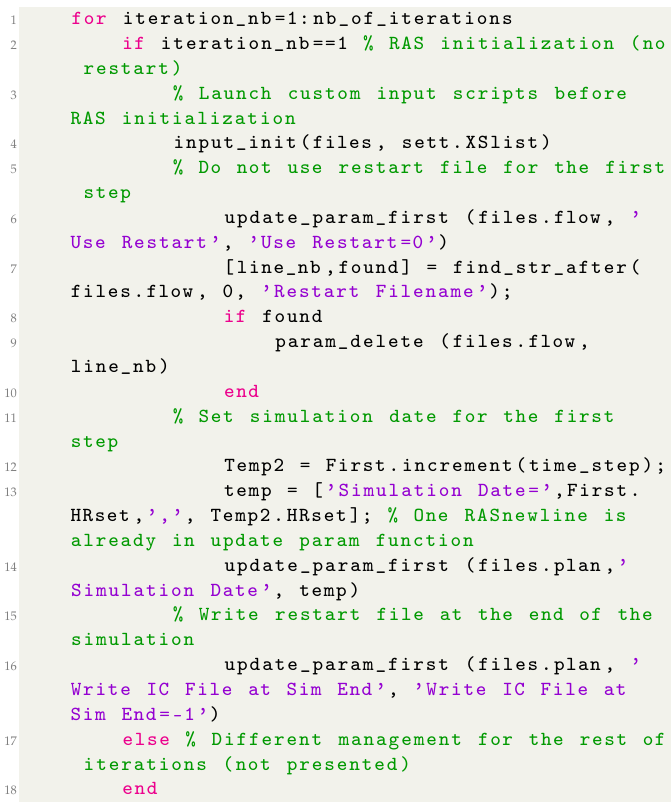
Figure 1. Diagram of the MATLAB HEC-RAS interface